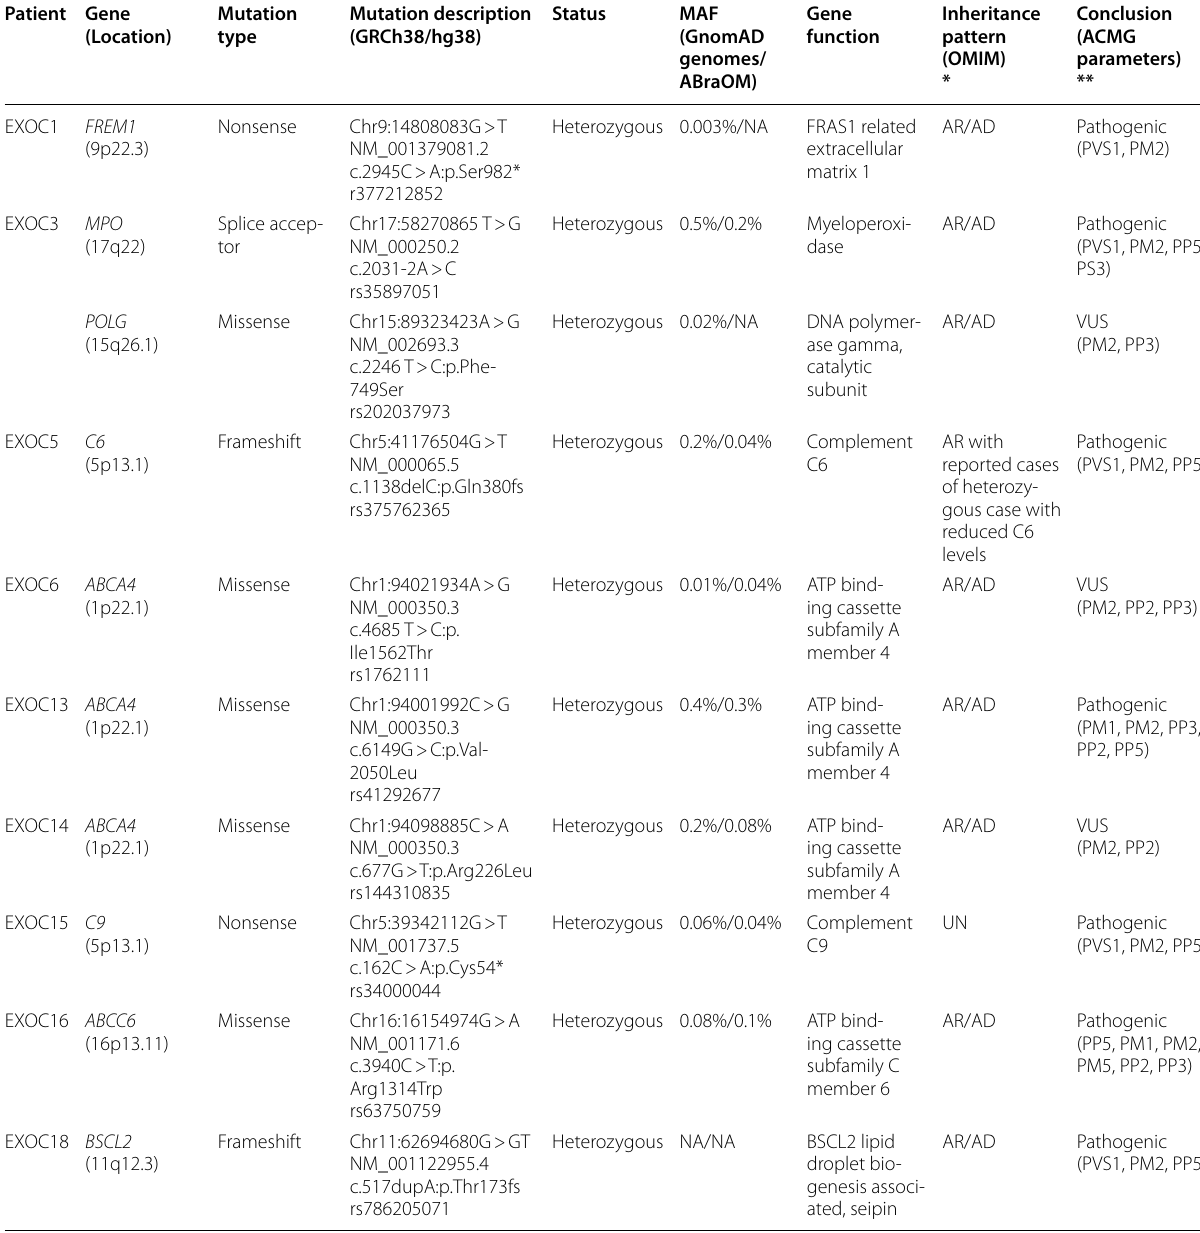
VUS: variant of unknown significance; NA: not available; *According to OMIM—Online Mendelian Inheritance in Man ® ; **According to ACMG guidelines (Richards et al, 2015) and